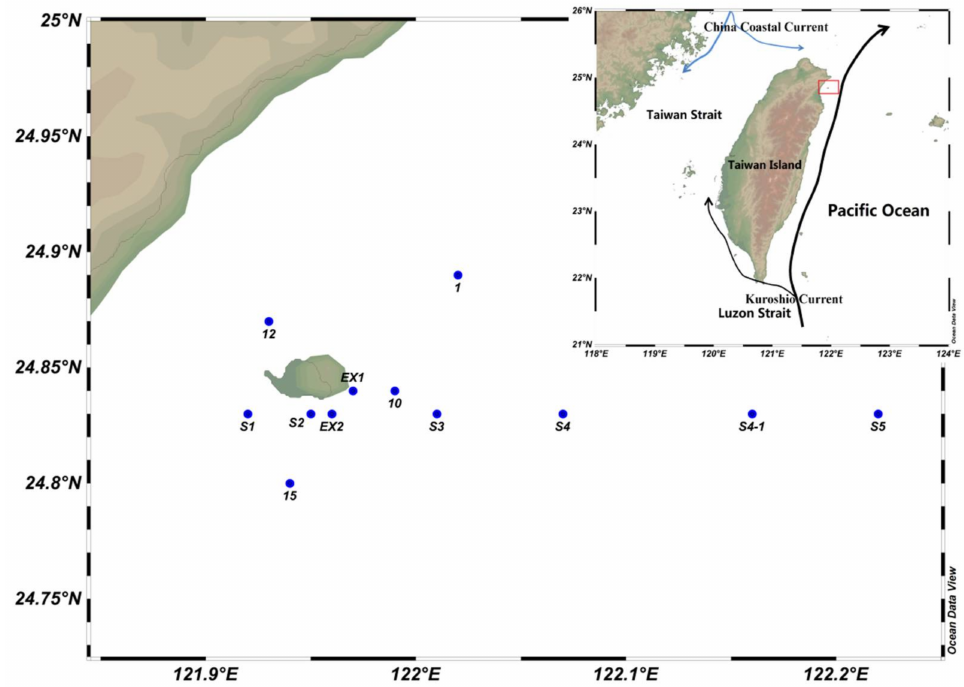
Figure 1. Sampling stations in the area of investigation along the northeastern Taiwan